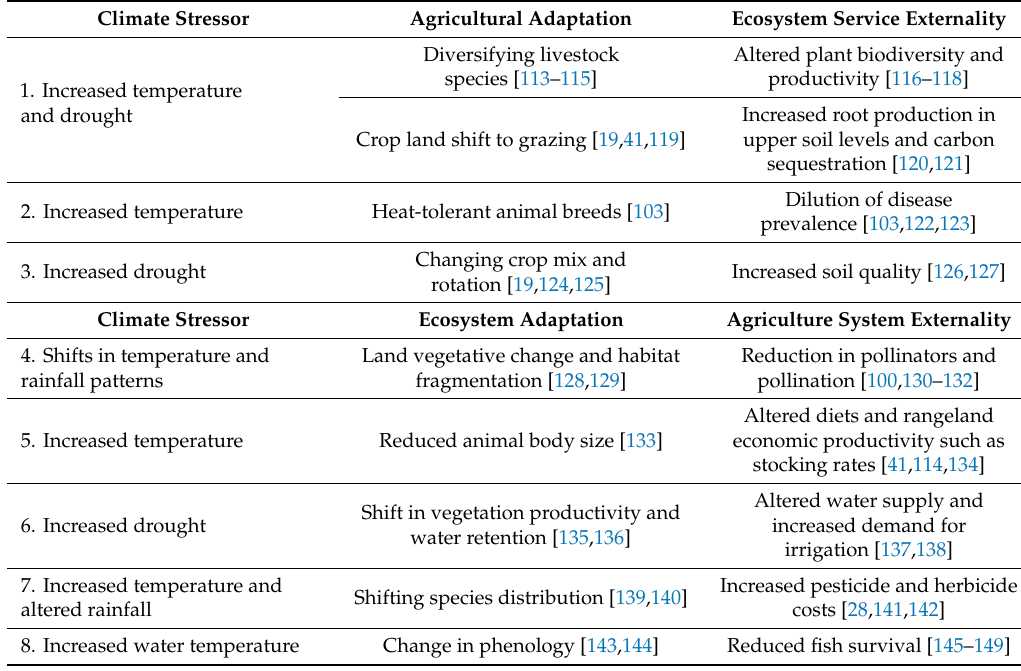
Table 2. Eight examples of how climate stressors lead to adaptation in agriculture and the corresponding response in ecosystems which can be a positive or negative externality. The opposite case of adaptations in ecosystems and responses in agriculture is then